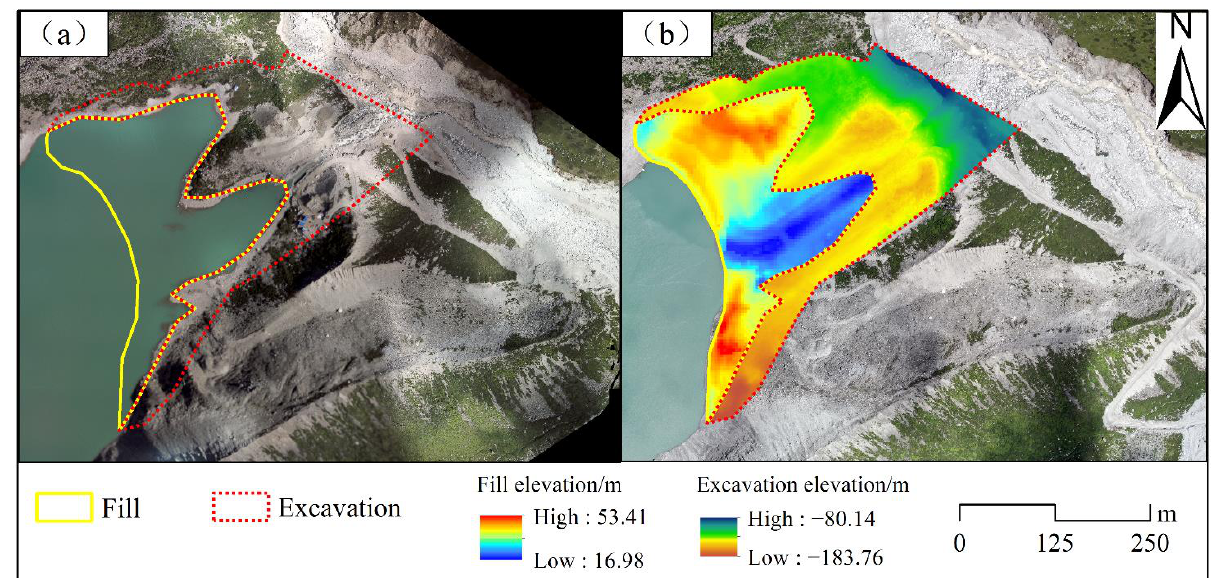
Figure 9. Earthwork calculation before and after the Jialong Co glacial lake comprehensive engineering management. ( a ) Range of fill and excavation. ( b ) Difference in elevation change within the fill and excavation area.